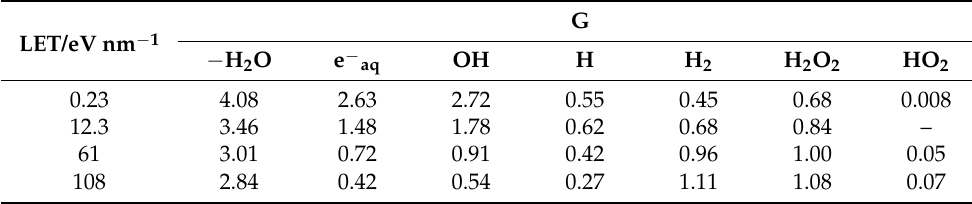
Table 11. Radiolytic yields as a function of LET (after Elliot, et al.